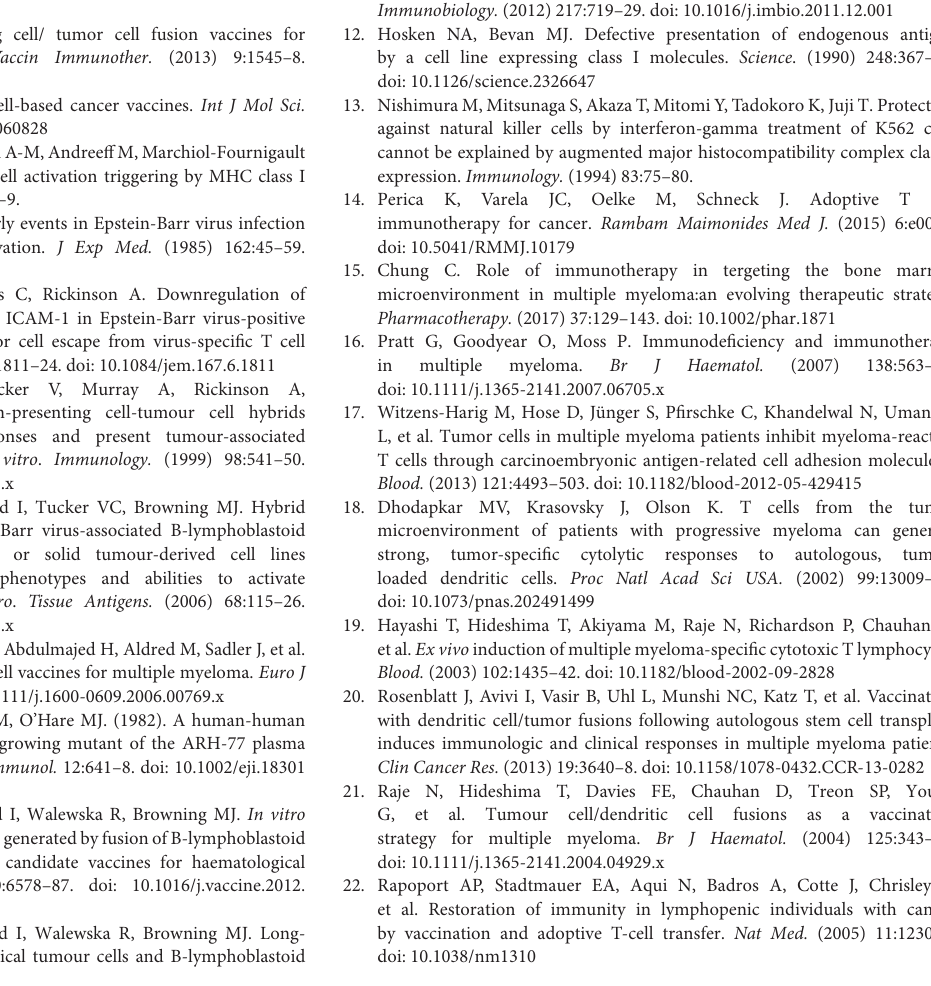
Supplementary Table 2 | Numbers of PBMCs after each stimulation in a representative example of one stimulation experiment. Supplementary Figure 1 | Percentages of positive MUC1, h TERT, CS1, MAGE-C1 and WNF HLA-A ∗ 201 restricted, PE peptide pentamer-stained CTL clones. PBMCs isolated from four HLA A2- patients with MM were stimulated in vitro for 4 weeks using the hybrid cell lines HRC and HU266, or the parent cell lines HMY2 and U266 as stimulators. The cultures were stained with HLA-A2-peptide pentamers incorporating cognate peptide antigen form MUC 1, hTERT, CS1, MAGE-C1, or the irrelevant WNF peptide, followed by flowcytometric analysis. Responses of individual cell lines are shown on the X-axis. Percent of pentamer-positive cells is shown on the Y-axis. Results are presented as mean ± SEM. Supplementary Figure 2 | IFN γ ELISpot assays. Responder cells (PBMCs, isolated from three different HLA-A2- MM patients and stimulated with HMY2, HU266, HRC or U266) were mixed with T2 stimulator cells after pulsing with MUC1, h TERT, CS1, MAGE-C1 or WNF derived peptides) in IFN γ ELISpot assays. Responder:stimulator cell ratios are shown on the X-axis. Number of elicited spots is shown on the Y-axis. Data are presented as mean value of the patients’ responses ± SEM. Stimulated PBMCS in the long-term culture of the used cell lines without further stimulation were used as a negative control in each corresponding ELISpot assay of the same cell lines. (There were insufficient cells in the cultures to perform perforin Elispot assays).